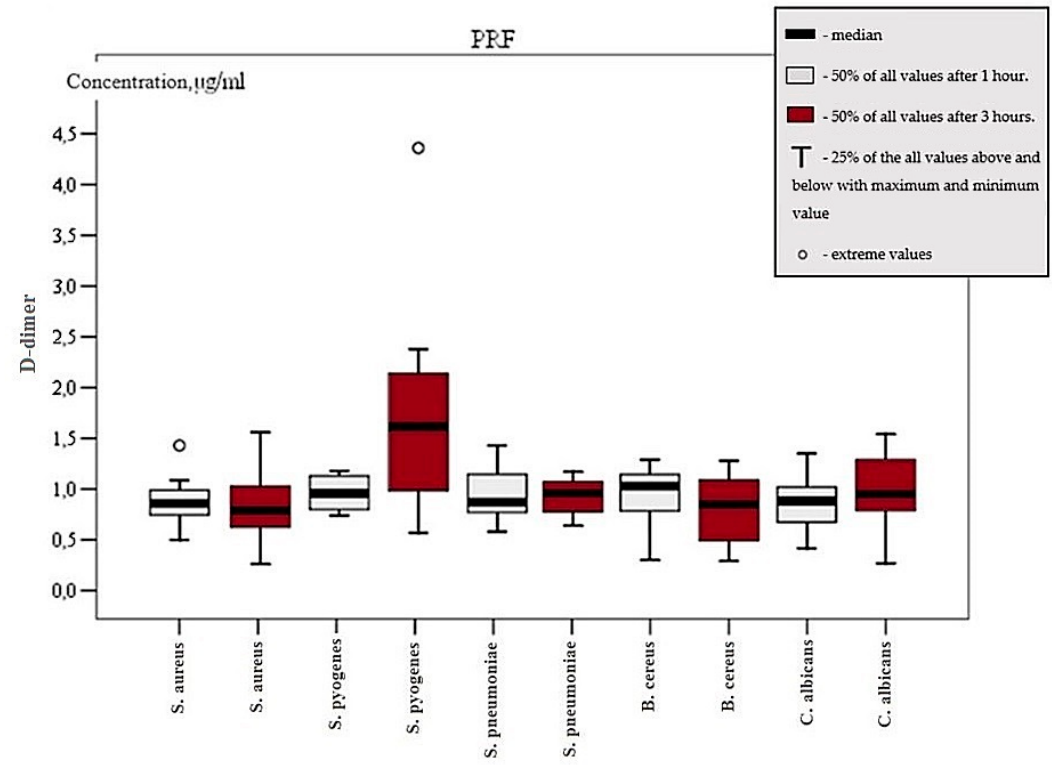
Figure 2. D -dimer concentration in PRF group between first and third hour. Figure 2. d -dimer concentration in PRF group between first and third